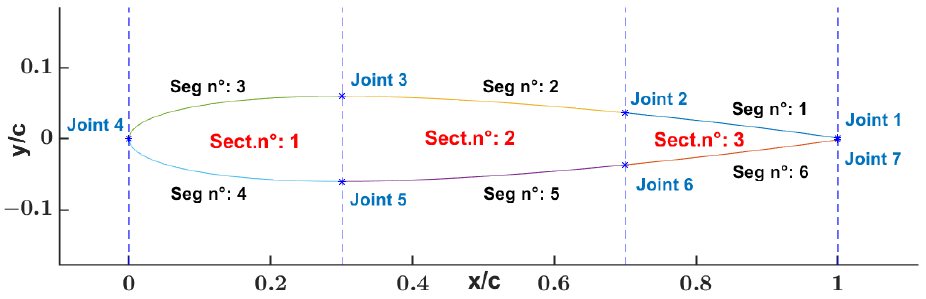
Figure 5. Partitioned NACA 0012 airfoil, segments represented in different colors.